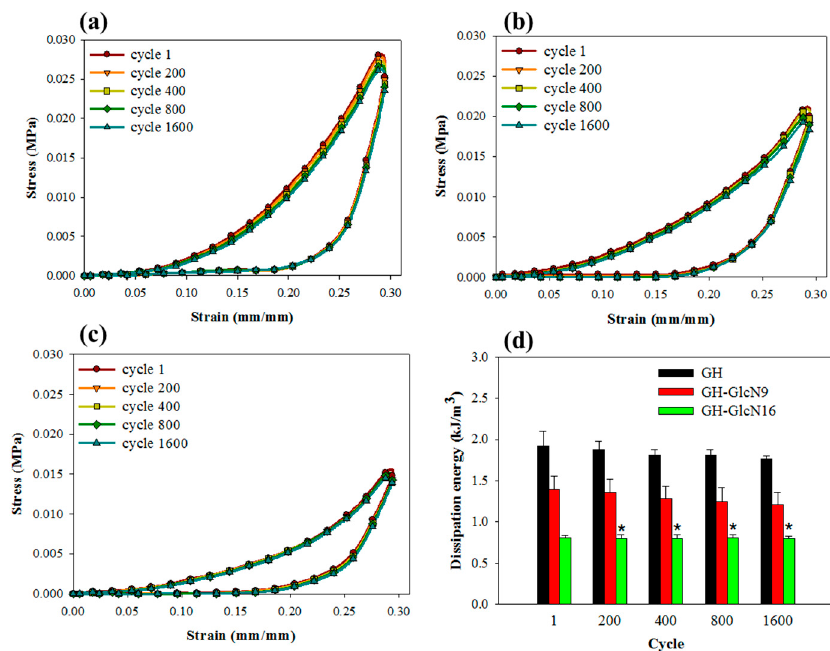
Figure 5. The loading–unloading hysteresis curves during 1600 successive compressions to a maximum strain of 0.3 for ( a ) GH; ( b ) GH-GlcN9; and ( c ) GH-GlcN16 cryogels. ( d ) Dissipation energy during hysteresis of cryogels calculated from the loop area in the loading–unloading hysteresis curve during different compressive cycles. * p > 0.05 compared with GH-GlcN16 cycle 1.